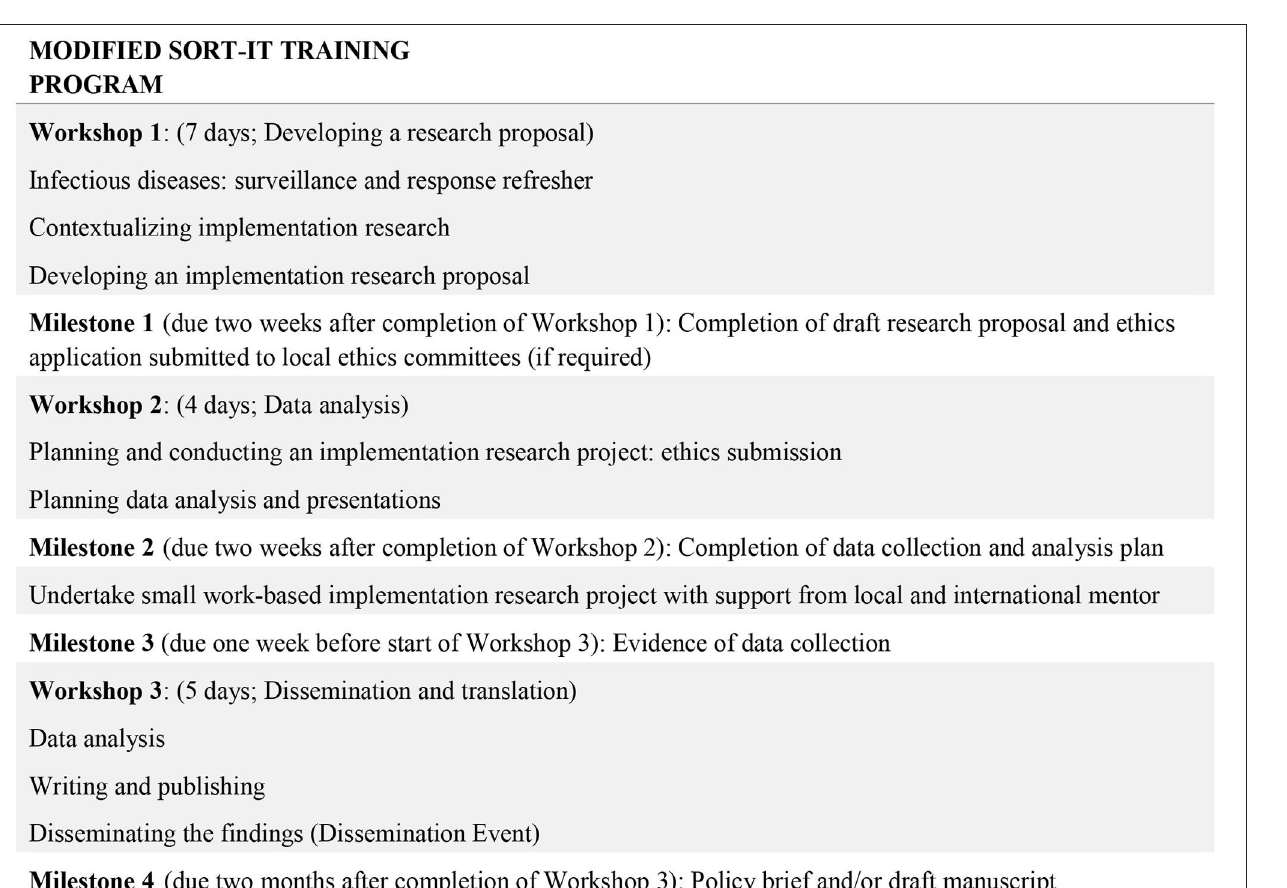
FIGURE 2 | Structure and milestones of the modified SORT-iT program used in the Indo-Pacific for the Partners in Tropical Health